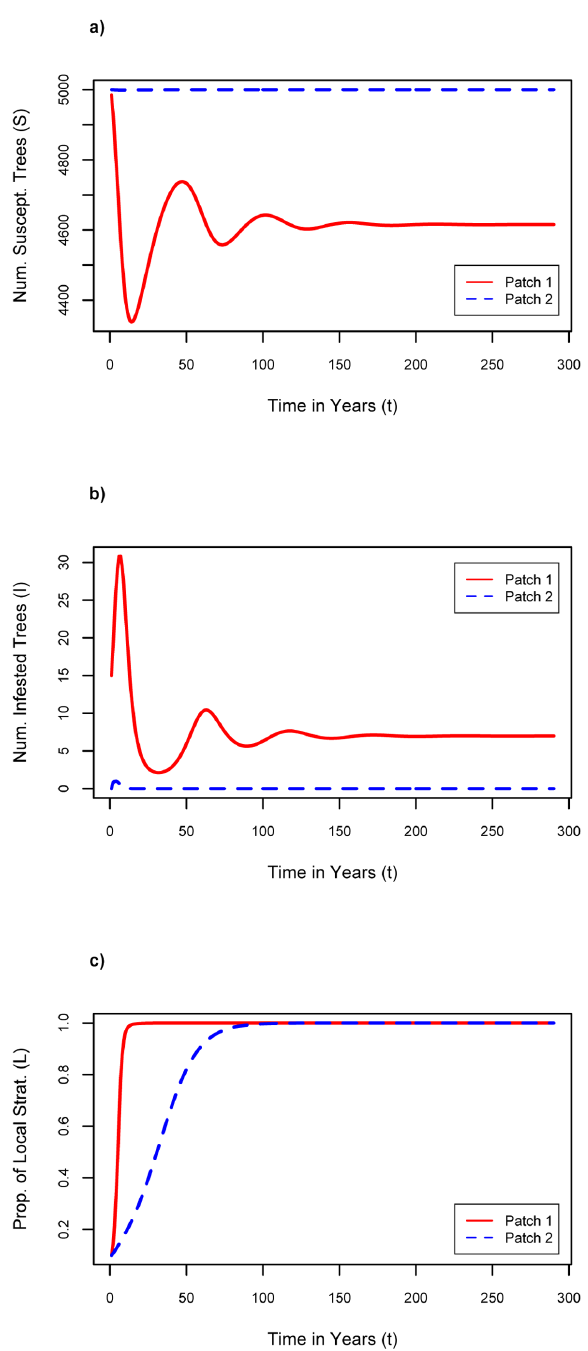
Figure 6. Results of increasing concern while decreasing cost of local firewood. Increase concern while decreasing cost: n=0.1, s =0.1, where a) number of susceptible trees as a function of time with f=0.2, Cl= $ 4.25; b) number of infested trees as a function of time with f=0.2, Cl= $ 4.25; c) proportion of local firewood strategists as a function of time with f=0.2, Cl= $